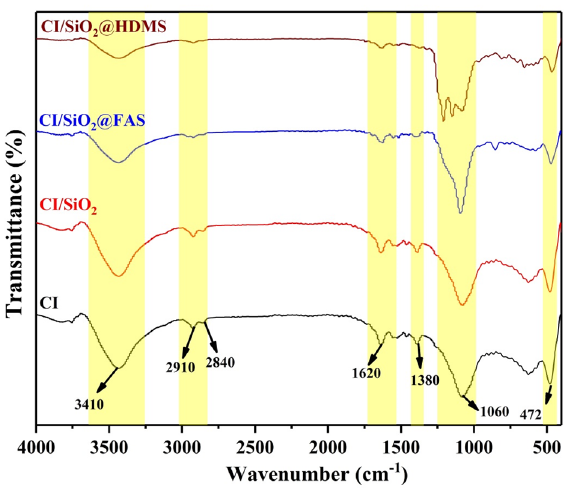
Figure 2. FTIR of carbonyl iron and modified hydrophobic particles with SiO 2 , SiO 2 @FAS, and SiO 2 @HDMS.